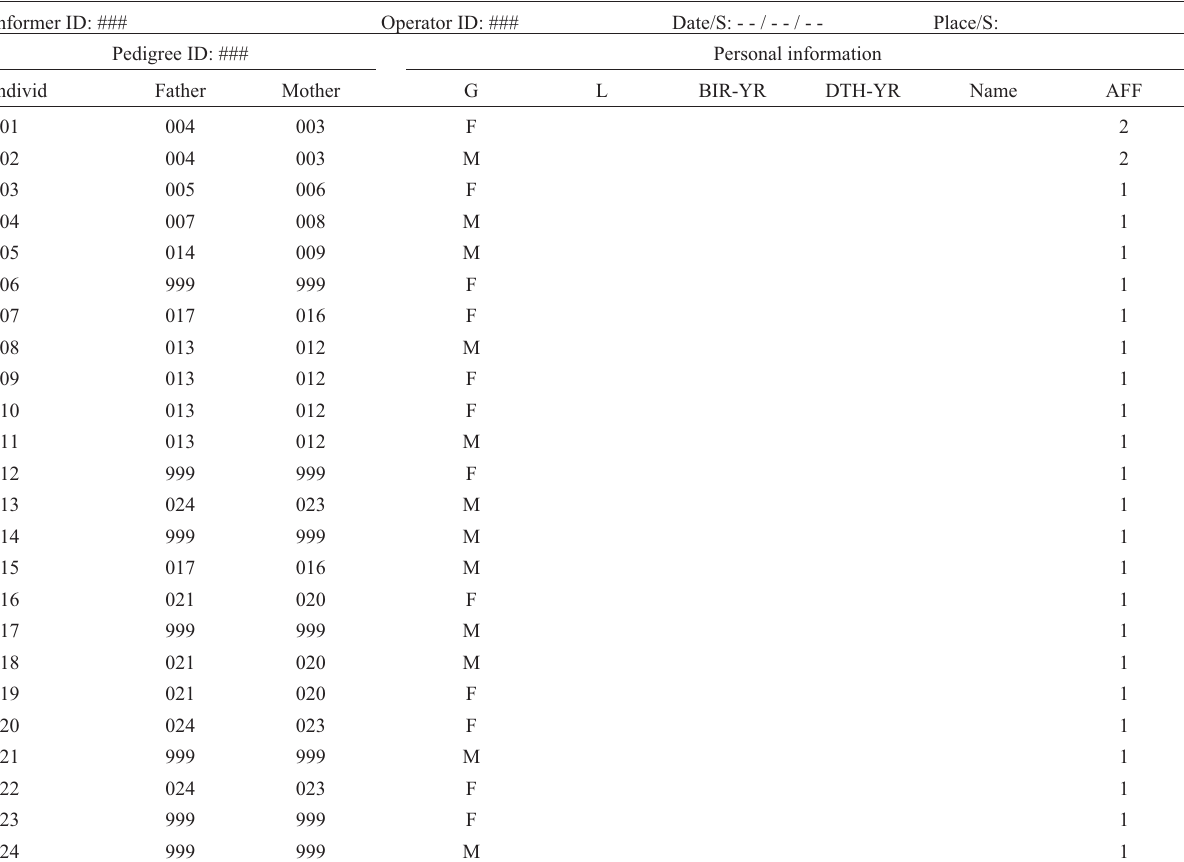
Table 1 - Tabulated genealogy: Data collection form. Informer ID: